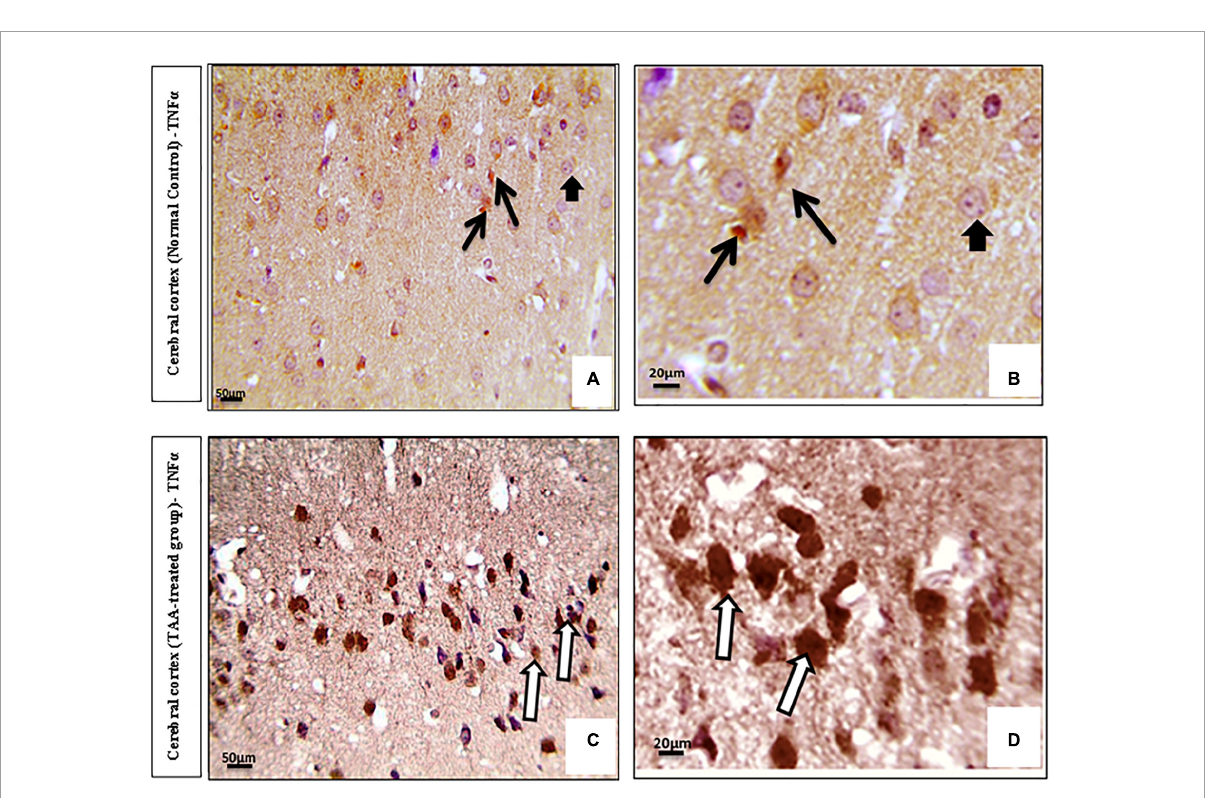
FIGURE8 (A–D) Microscopic pictures of immunostained cerebral cortical sections against TNF α of control and treated groups. (A,B) Control group showing mild expression (black arrows) or negative staining (short arrows) in astrocytes. (C,D) Cerebral cortical sections from the TAA administrated group demonstrating strong positive brown astrocytic staining (area of gliosis) (white arrows). X: 400 bar 50 and X: 1000 bar